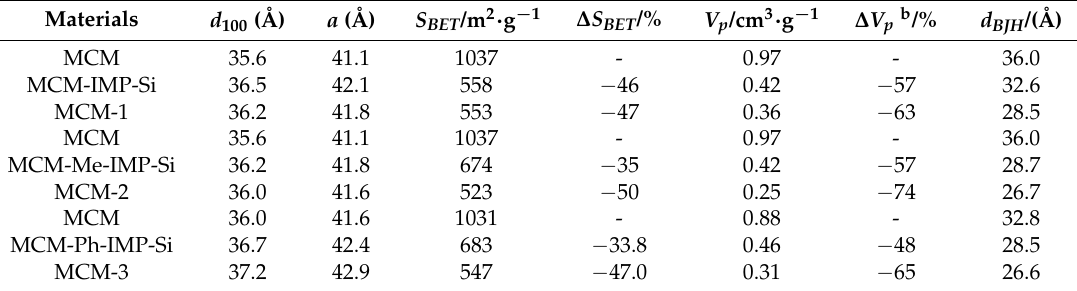
Table 2. Textural parameters of host and composite materials from powder XRD and N 2 isotherms at